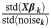
Performance of BRSA and other methods on simulated data.(A) We simulate task-related activation magnitude according to a multivariate normal distribution with a hypothetical “true” covariance structure U as displayed. (B) We use lateral occipital cortex (bright region) as an example ROI and resting state fMRI data from the Human Connectome Project as noise. (C) We multiplied the design matrix of the task in Fig 1A with the activity pattern simulated according to A and then added this “signal” to voxels in a cubical region of the ROI. The colors show the actual SNR of the added signal for one example simulated brain, corresponding to the plot circumvented by a red square in F. SNR here is defined as the ratio of standard deviation of the simulated signal to that of the noise (the time series of the resting state fMRI data): std(Xβ·k)std(noisek), where noisek is the time series of the resting state fMRI data in voxel k, treated as task-irrelevant noise in our simulation. (D) The pseudo-SNR map estimated by BRSA for the data with a true SNR map shown in C. The scale does not match the scale of true SNR, but the spatial pattern of SNR is recovered. The result corresponds to the simulation condition with red box in F. (E) The distributions of the fitted pseudo-SNR of task-active (pink) and inactive (blue) voxels are highly separable. The inset shows the SNR in active voxels and their fitted pseudo-SNR are significantly correlated. r = 0.62, p<1.4e-20. (F) Average covariance matrix (top) and similarity matrix (bottom) estimated by BRSA in the cubic area in C, across different SNR levels (columns) and different numbers of runs (rows). The average SNRs within the voxels with signals added (i.e., voxels with color in C) are displayed at the bottom. Note that we do not expect the values in the covariance or correlation matrix to scale linearly with SNR. The major effect of SNR is that the similarity structure becomes noisier as SNR decreases. (G) The corresponding result obtained by standard RSA based on activity patterns estimated within runs, which are spatially whitened. The major effect of SNR is that bias structure is stronger in the result as SNR decreases. (H) The corresponding result of RSA based on cross-correlating patterns estimated from separate runs, which are spatially whitened based on the residuals of all scanning runs. The major effect of SNR is noisier result and smaller correlational coefficients overall as SNR decreases. (I) Top: average correlation (mean ± std) between the off-diagonal elements of the estimated and true similarity matrices, for each method, across SNR levels (x-axis) and amounts of data (separate plots). Bottom: The correlation between the average estimated similarity matrix of each method (for GBRSA, this is the single similarity matrix estimated) and the true similarity matrix. “point-est”: methods based on point estimates of activity patterns; “-crossrun”: similarity based on cross-correlation between runs; “-whiten”: patterns were spatially whitened.